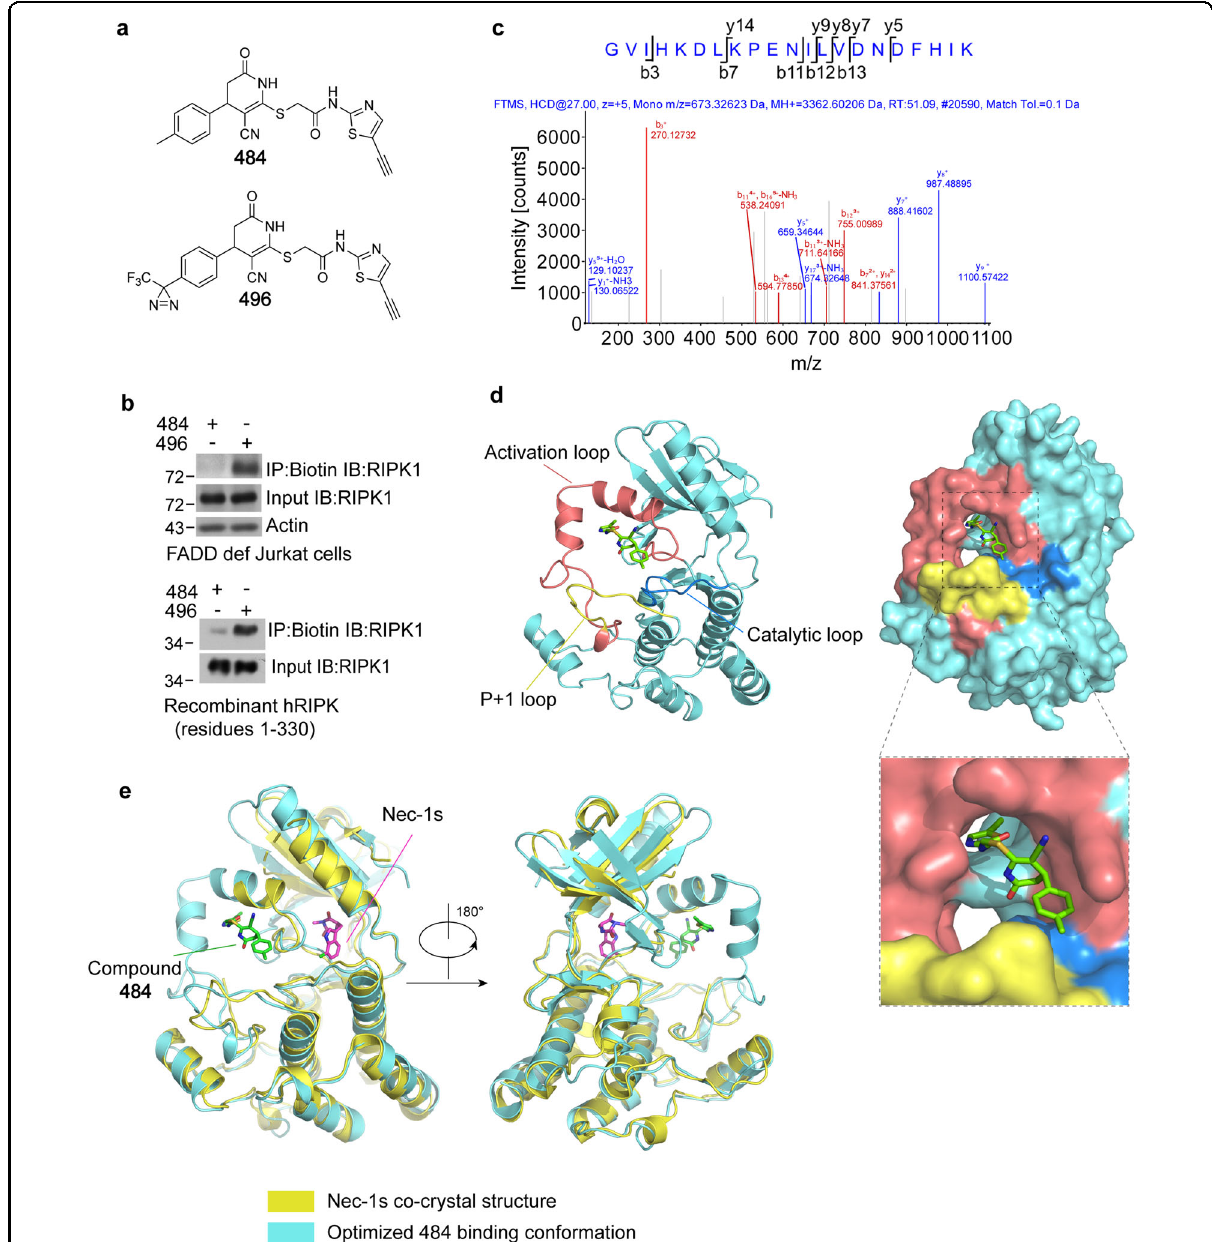
Fig. 4 Identi fi cation of Nec-34-binding motifs in RIPK1 kinase. a The chemical structures of the photo-af fi nity probe compound 496 for Nec-34 and the photostable control compound 484. b FADD-de fi cient Jurkat cells were pretreated with 20 μ M 484 or 496 for 1 h and then cells were lysed with Nonidet P-40 buffer. The cell lysates (upper blot) or puri fi ed hRIPK1 (residues 1 – 330, lower blot) were individually treated with 200 μ M 484 or 496 for 30 min. Samples were subjected to photo-crosslinking assay and enriched by streptavidin-coupled beads. All isolated complexes and whole-cell lysates were analyzed by western blotting with indicated antibodies. c Identi fi cation of Nec-34-binding sites by mass spectrometry. hRIPK1 (residues 1 – 330, 50 μ g) was labeled by incubating with photo-af fi nity probe 496 after UV-crosslinking. After click-chemistry reaction and biotin – streptavidin af fi nity puri fi cation, the enriched peptides of RIPK1 that bound with 496 were identi fi ed by mass spectrometry. MS/MS of a hRIPK1 peptide 133- GVIHKDLKPENILVDNDFHIK-153 crosslinked with biotinylated compound 496 is shown. The ion b3, b7, b11, b12, b13 are annotated with a mass shift + 918.2587Da. d Cartoon (left) and surface mode (right) of computationally optimized binding conformation of compound 484. The RIPK1 structure was obtained from RCSB PDB dataset (ID 6C4D) and the missing activation loop atoms were built with Modeler. The catalytic loop (Gly133 – Asn143) was colored blue, the activation loop (Asp156 – Glu196) was colored red, the P + 1 loop (His197 – Thr206) was colored yellow, other parts of RIPK1 kinase domain were colored cyan. Compound 484 was shown in green sticks. e Alignment of computational binding mode of compound 484 in d with the co-crystal structure of RIPK1 and Nec-1s (PDB 4ITH). 484-bound RIPK1 was colored cyan, Nec-1s-bound RIPK1 was colored yellow. Compound 484 was shown in green sticks and Nec-1s was shown in magenta